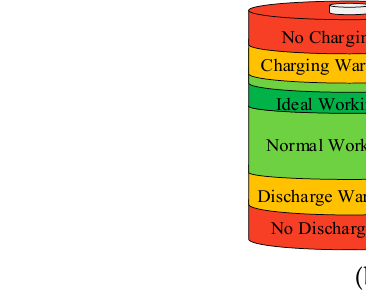
Figure 5. Schematic diagram of working status division ( a ) Battery; ( b ) Super capacitor.